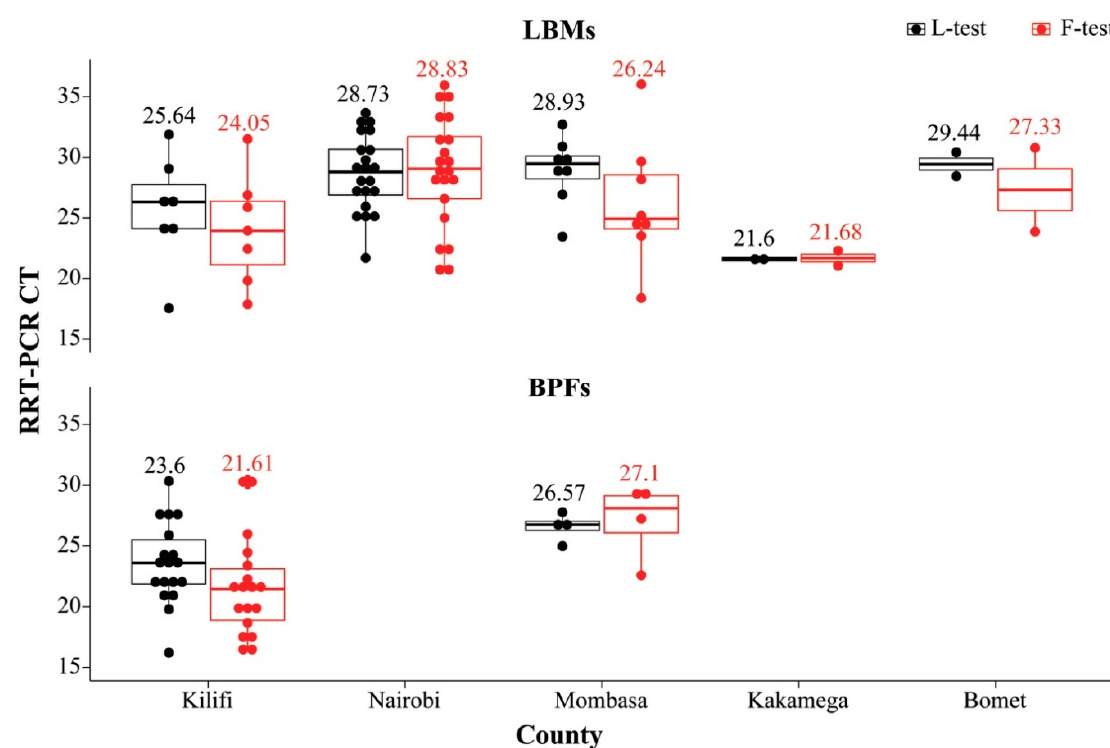
Figure 2. Plot of 62 indigenous chickens sampled from LBMs and BPFs in five Kenyan counties that were confirmed as NDV-positive by the rRT-PCR L- and F-test (in black and red, respectively). The mean rRT-PCR C T values obtained from each of the two tests are shown. Note that there were no BPF birds from Nairobi county, and all the BPF birds sampled from Bomet county had C T values above 30.